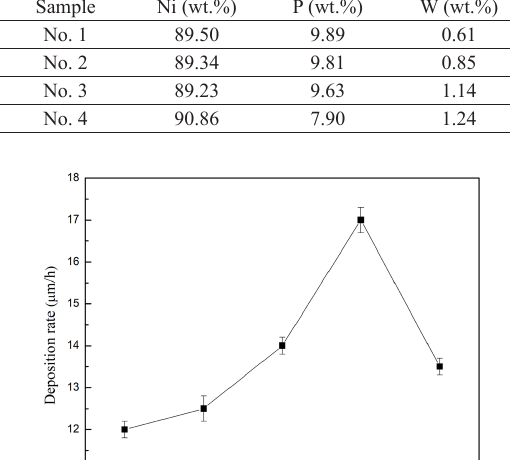
Figure 4. Effect of the concentration of Na on deposition rate.